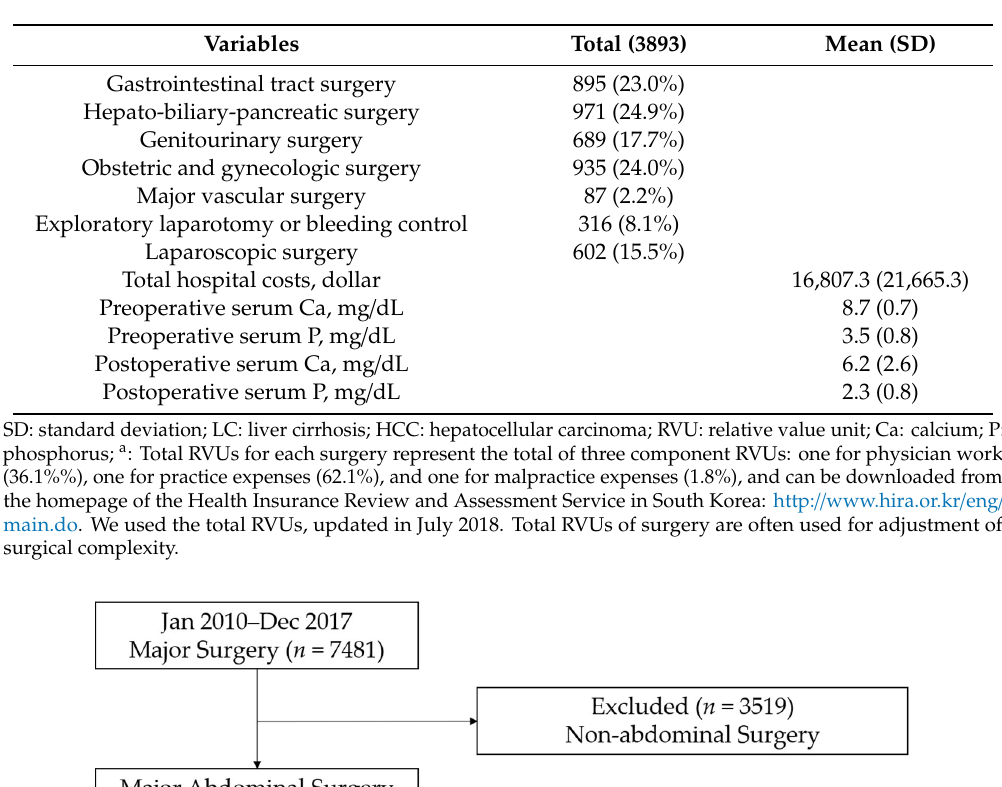
Table 2. Univariable linear regression analysis for total costs ($) and length of hospital stay (day) after major abdominal surgery.